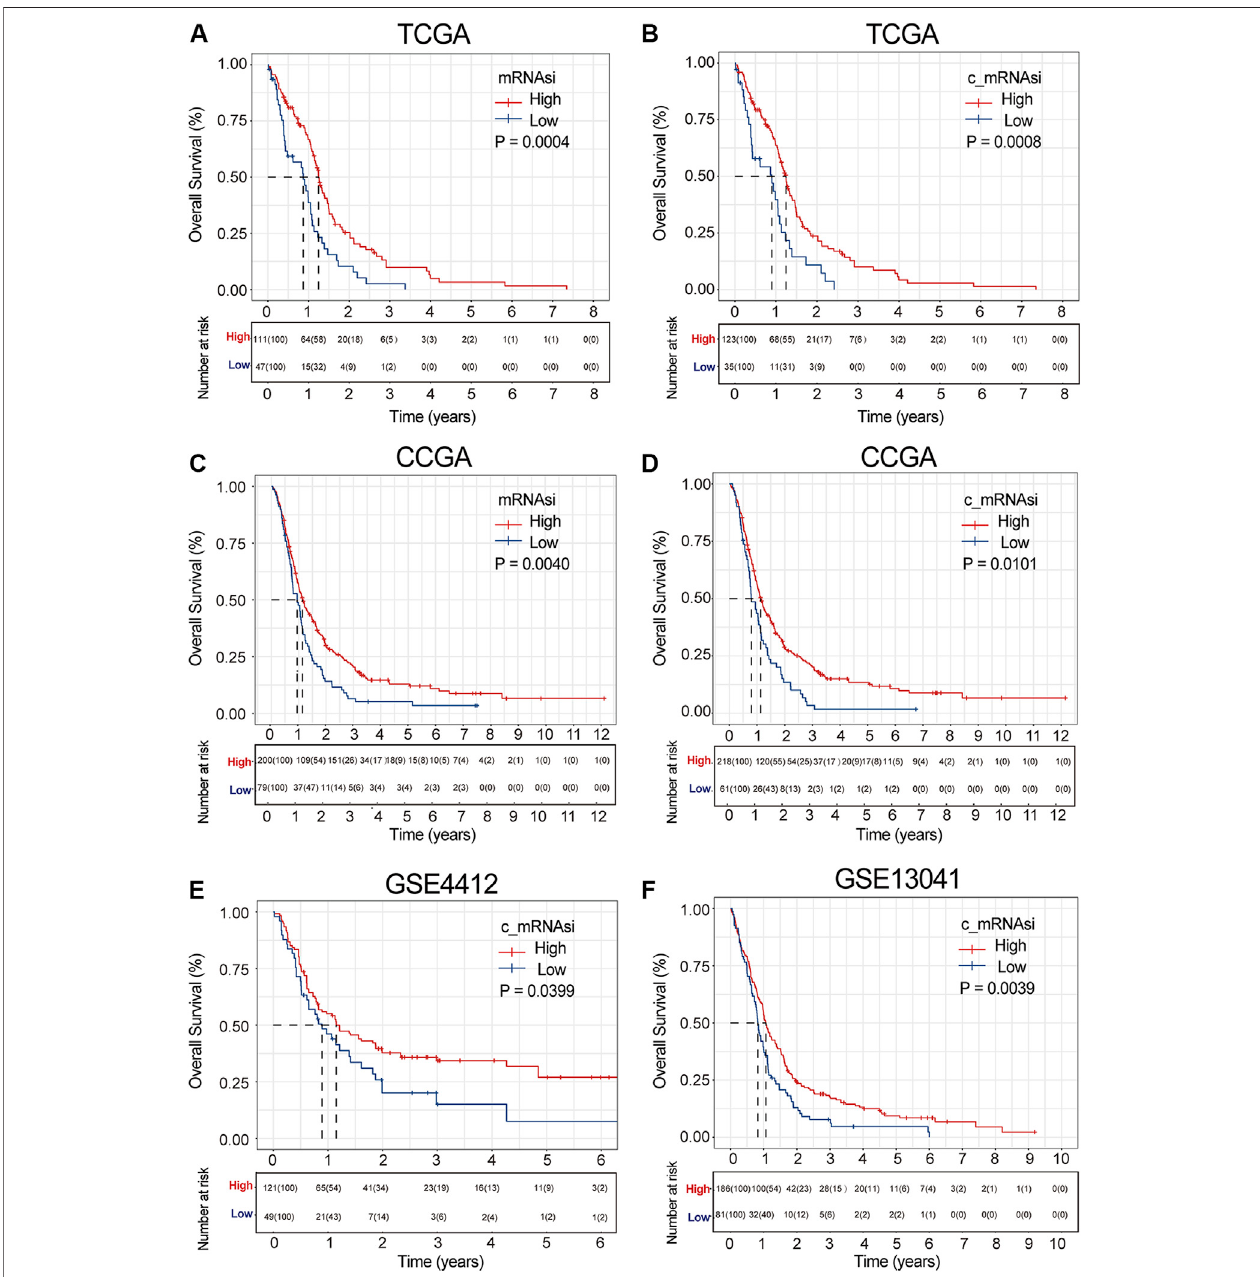
FIGURE2| SurvivalcurveofmRNAsi/c_mRNAsionprognosis. (A) .OverallsurvivalcurveofmRNAsiinTCGA. (B) .Overallsurvivalcurveofc_mRNAsiinTCGA. (C) . Overall survival curve of mRNAsi in CGGA. (D) . Overall survival curve of c_mRNAsi in CGGA. (E) . Overall survival curve of c_mRNAsi in GSE4412. (F) . Overall survival curve of c_mRNAsi in